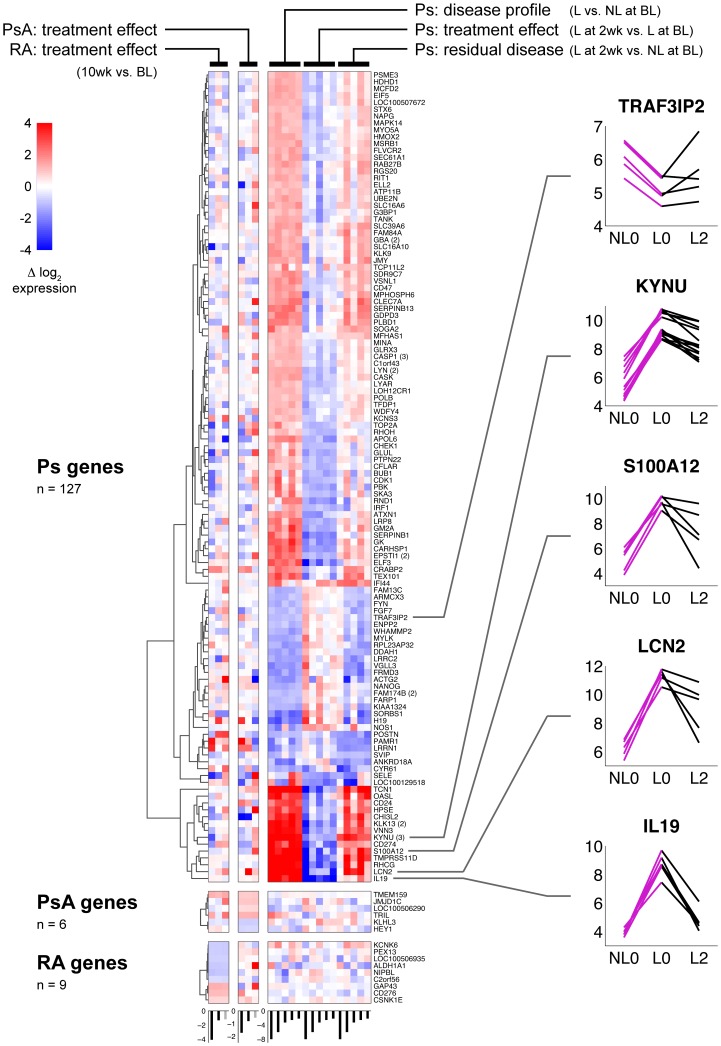
Heat map of IFX treatment effect in tissues.Paired t-tests were used to identify significant probe sets in different tissues. For Ps, comparisons, probe sets were selected where p<0.0005 and there was at least a 2-fold change in expression. For RA and PsA, paired t-tests were used and probe sets were selected where p<0.001 with at least a 1.5-fold change. Ps, PsA and RA probe set lists comprise the sets of rows, and RA, PsA and Ps samples comprise sets of columns. Color is the log2 difference in expression. Probe set clustering (Euclidean distance, complete linkage) was based on the corresponding sample type. BL: baseline, L: lesional, NL: non-lesional skin. Five genes are highlighted: each line is a patient; violet, black segments are cross-sectional, longitudinal comparisons, respectively. Within each of the five groups of columns corresponding to the five comparisons at the top, patients (individual heat map columns) are sorted by change in disease activity. See legend for Figure 3 for details.